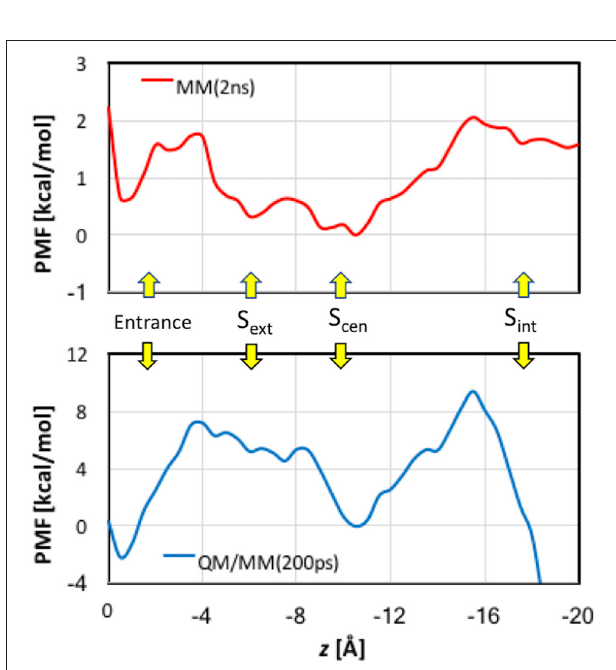
FIGURE 8 | Potentials of mean force for Cl − ion passage obtained by umbrella sampling simulations. Note the different scales in the MM and QM/MM plots.